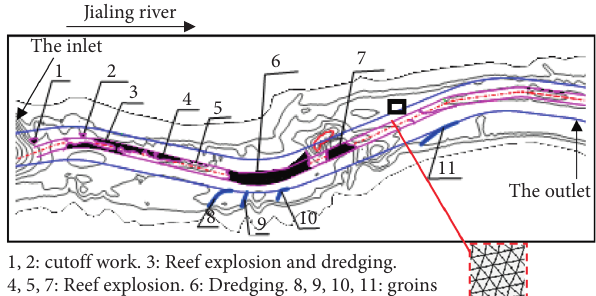
Figure 3: Sketch of the computational domain and the regulatory scheme for the channel.